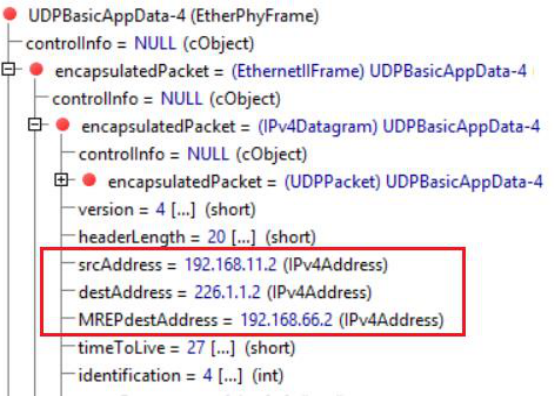
Figure 15. Second EM-REP run.